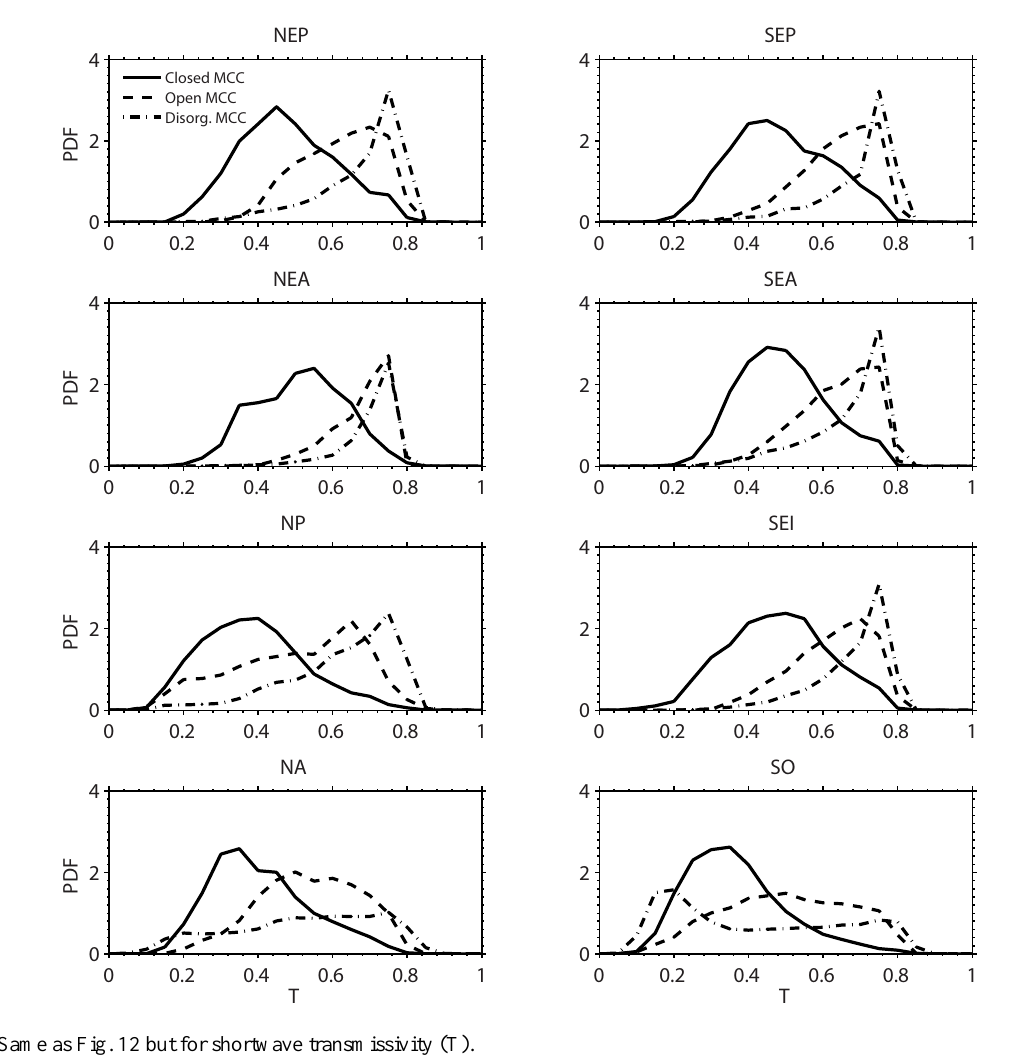
Figure 16. Same as Fig. 12 but for shortwave transmissivity